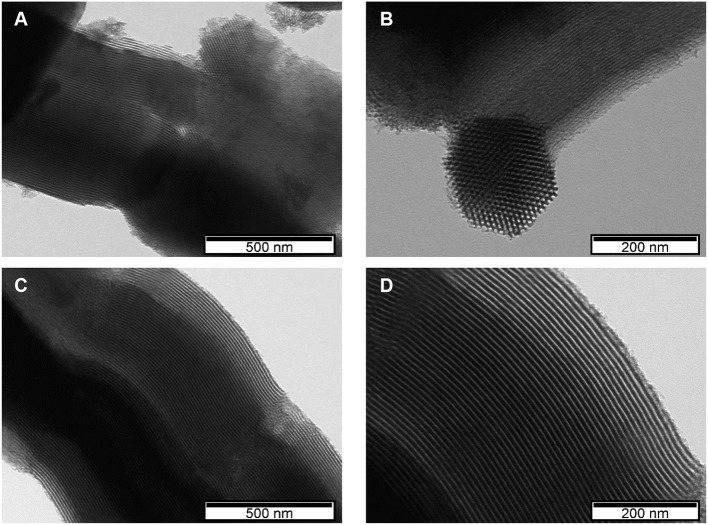
TEM images of the (A,B) PW11@TMA-SBA-15 and (C,D) PW11@TMA-PMOE composites at different magnifications.